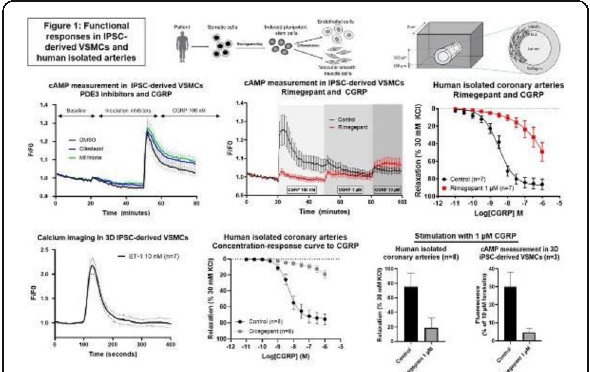
Fig. 1 (abstract P2). Functional responses in IPSC-derived VSMCs and human isolated